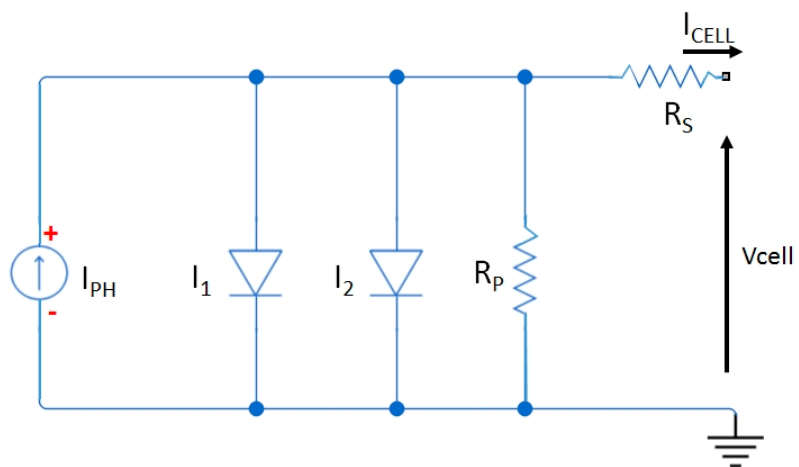
Figure 1. One-diode circuit model.